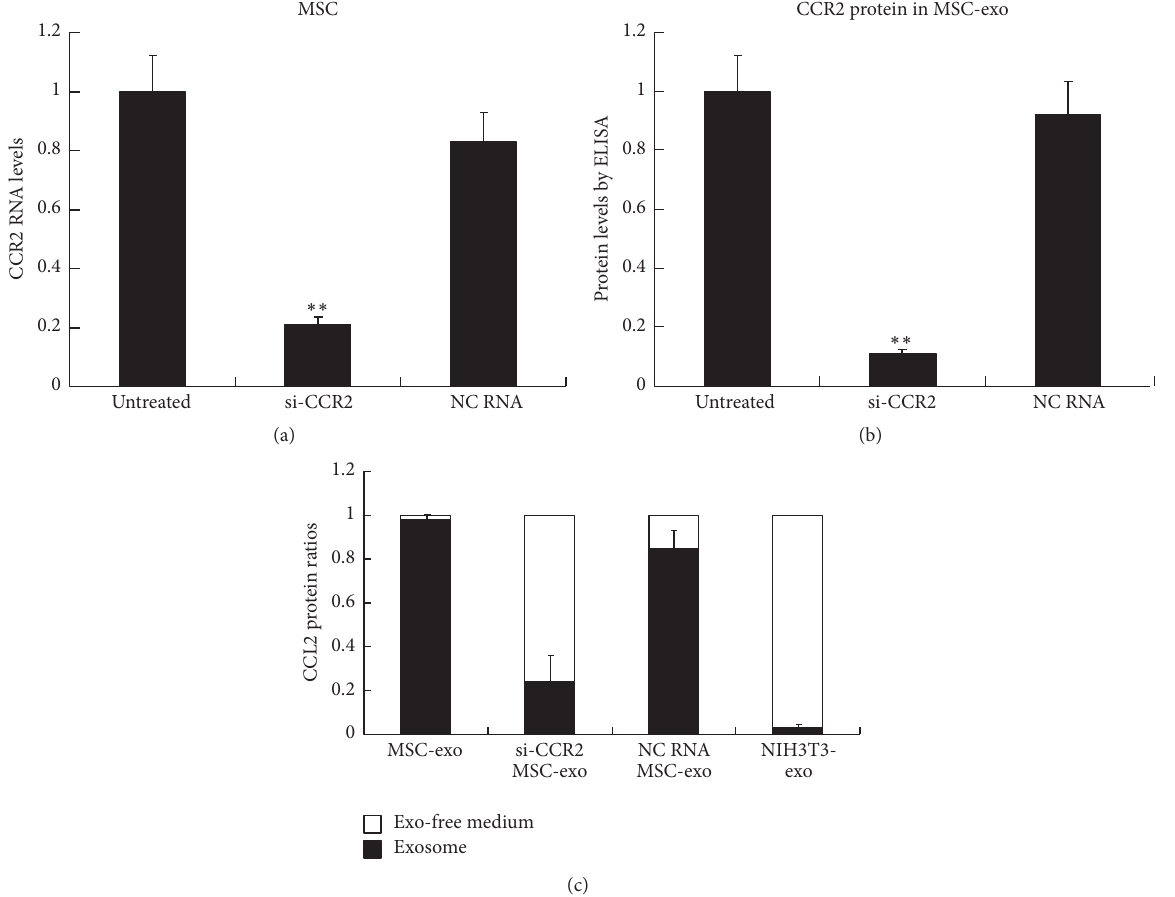
Figure 2: CCR2 knockdown MSC-derived exosomes failed to bind CCL2. (a) CCR2 knockdown efficacy in the MSCs. A CCR2-specific cocktail of siRNAs (si-CCR2) was transfected into the MSCs for 72 hrs, and a scramble RNA was used as a negative control RNA (NC RNA). Quantitative RT-PCR was used to analyze the changes of mRNA levels in these cells and the change folders for each group compared to untreated MSCs were shown. (b) CCR2 expression levels of the exosomes from the conditional mediums of treated MSCs. The CCR2 protein concentrations were determined by ELISA and the change folders for each group compared to untreated MSCs were shown. (c) CCL2 binding efficiency of exosomes. Recombinant mouse CCL2 protein (100ng per well) was incubated with the exosomes for 1 hour, as indicated by the groups. Then, the exosome-free (exo-free) medium and exosomes were separated by ultracentrifugation. Then, the free CCL2 protein levels in the medium were determined by ELISA analysis and the ratios of free CCL2/total CCL2 were shown. Bars represent standard error of the mean ± S.D from three repeats. All the significance was determined by ANOVA and Student’s 𝑡 -test. ∗∗ 𝑃 < 0.01